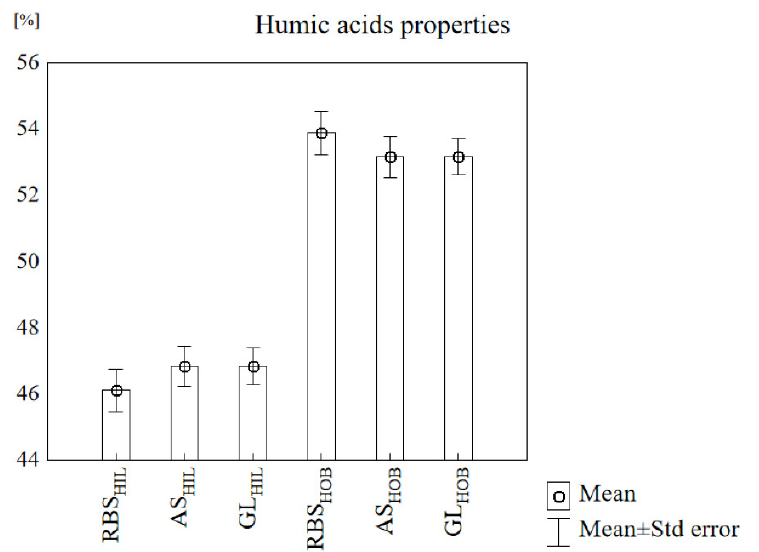
Figure 2. The percentage share of hydrophilic (HIL) and hydrophobic (HOB) fractions in humic acids isolated from riverbank sediments (RBS), arable soils (AS) and grassland soils (GL).